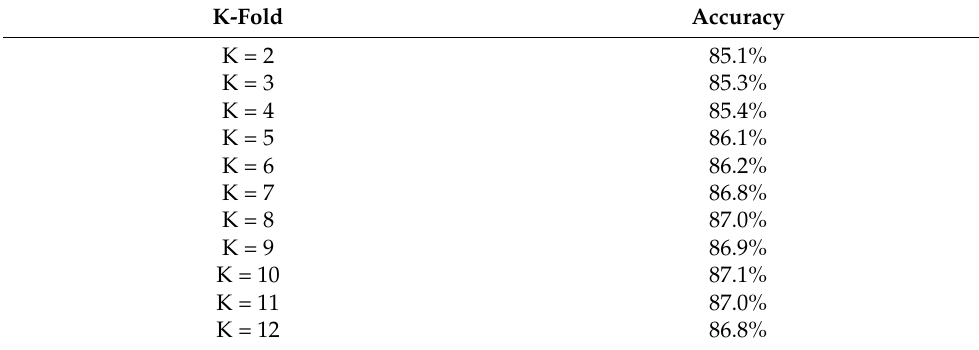
Figure 7. K-fold cross-validation. In this study, the EMG dataset used for learning was divided into ten. Table 3. Result by K value.